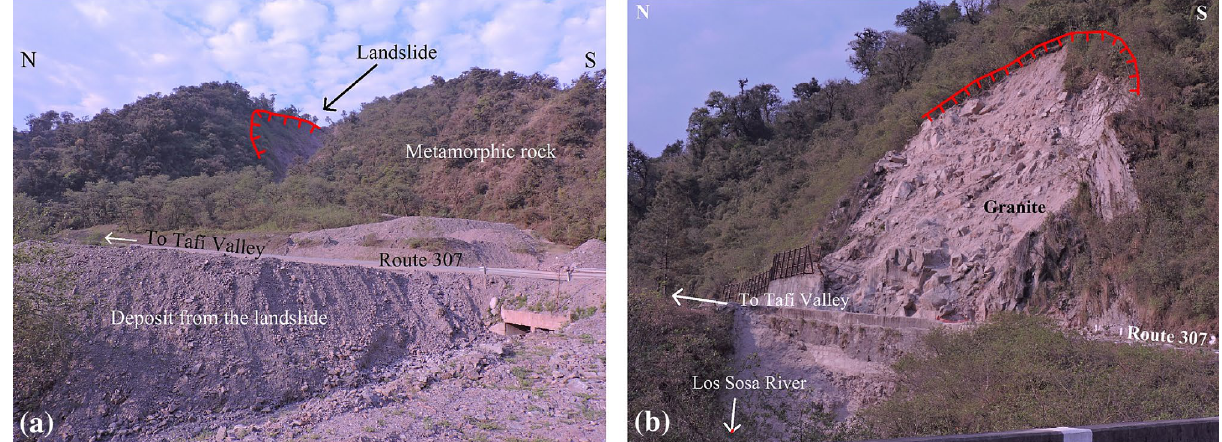
Fig. 4 a Azucena landslide on the left bank of the Los Sosa river (Chasquivil fault). b Fin del Mundo landslide on the left bank of the Los Sosa river (Chasquivil fault). Landslide scars are shown with red